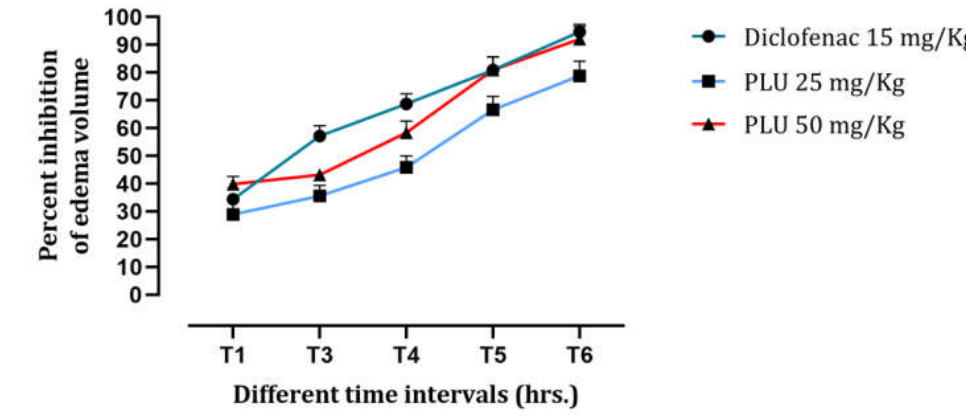
Figure 6. Effects of PLU on the edema development presented as inhibition percentage.